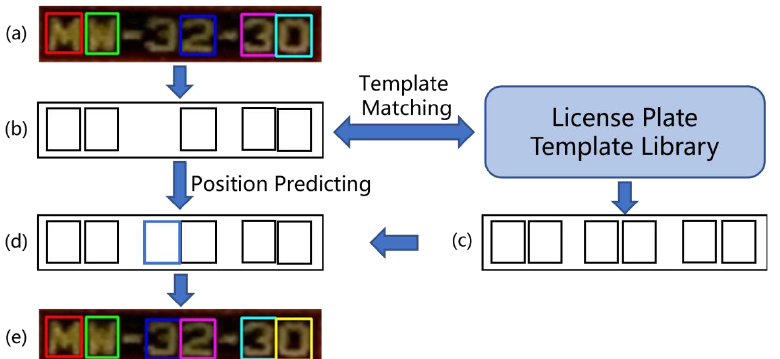
Figure 4. The flowchart of handling missing detection by the proposed TMPP. ( a ) is the detection result generated by ROI-based method, ( b ) shows the rectangles of detected regions, ( c ) is the selected template from license plate template library that matches with ( b ), ( d ) represents predicted result by template matching, ( e ) shows final detection result.